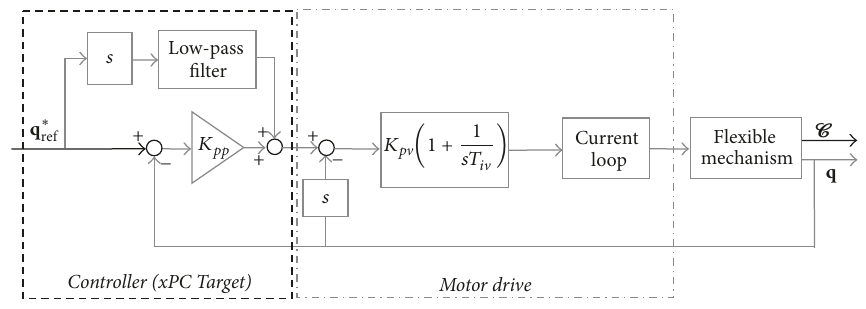
Figure 3: Inner control loop.